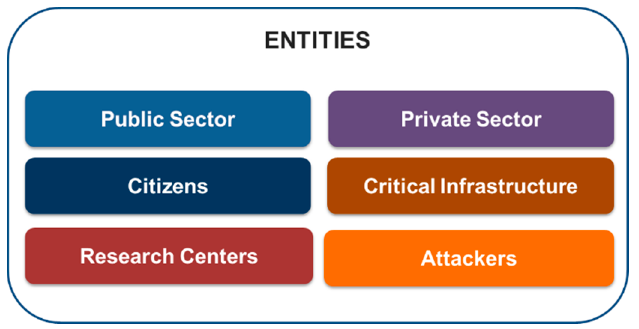
Figure 2. Entities in the Cyber security Ecosystem of Colombia.